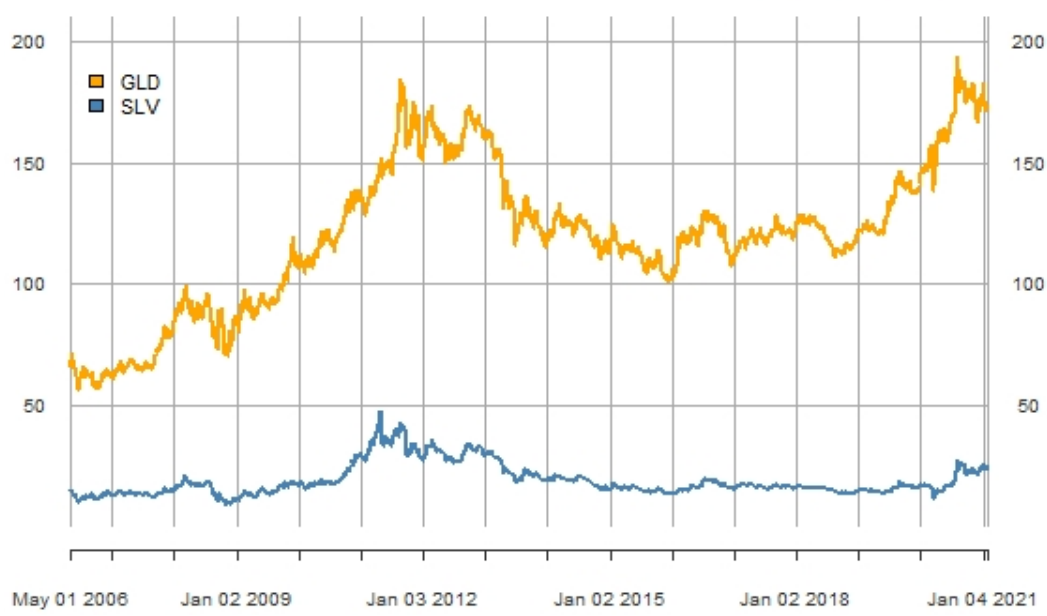
Figure 1. This figure shows gold (GLD) and silver (SLV) ETF prices across time. Data are sourced from Yahoo Finance. The histograms for the percentage of up days by forecast horizon shows little variation for GLD or SLV (Figure 2). The percentage of up days for GLD never gets higher than 55% while the percentage of up days for SLV never gets higher than 53%.